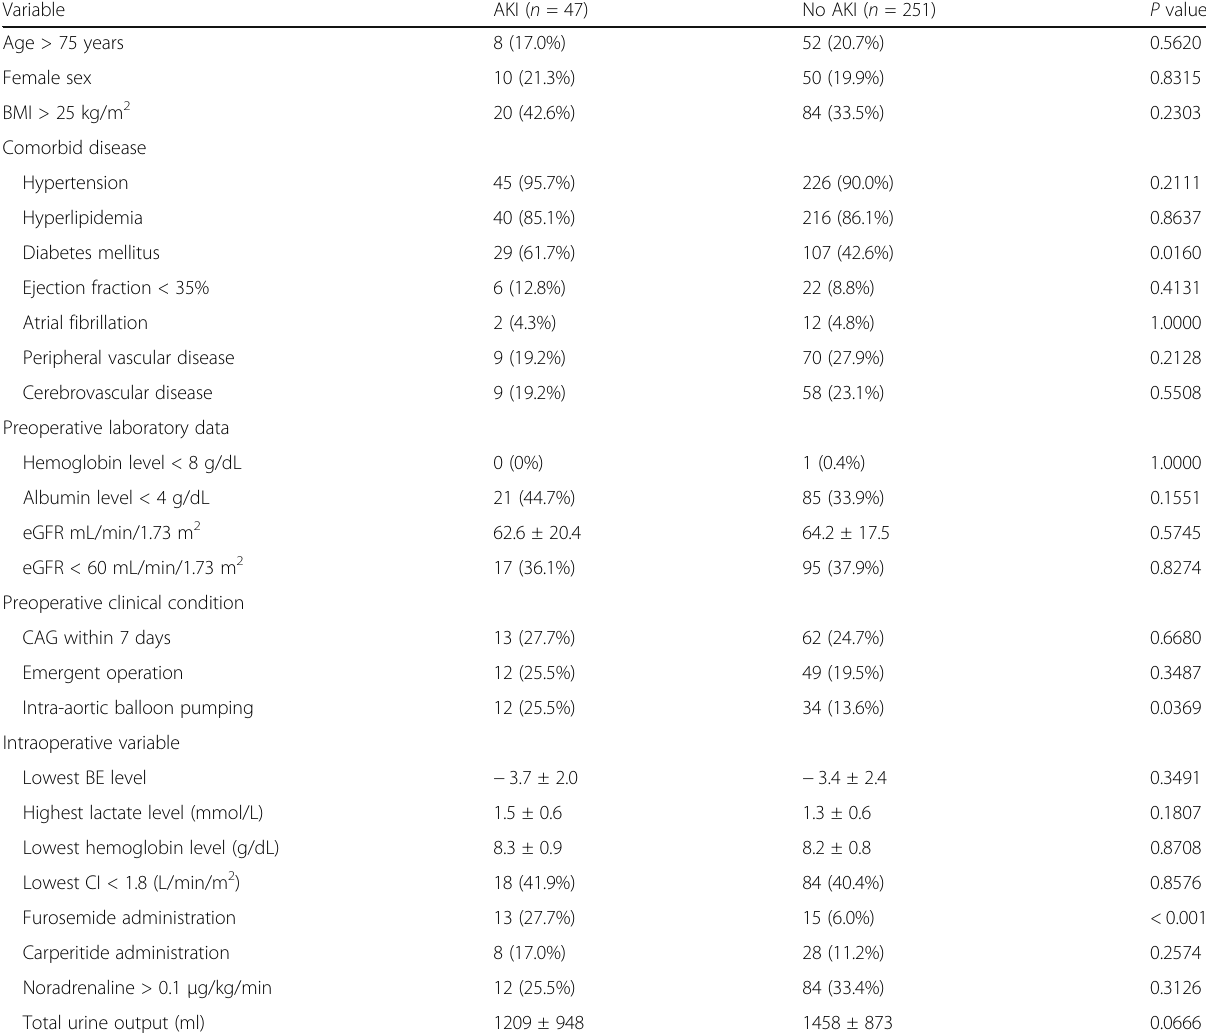
Table 3 Preoperative demographic characteristics and intraoperative variables in patients with or without AKI Variable AKI ( n = 47) No AKI ( n = 251)